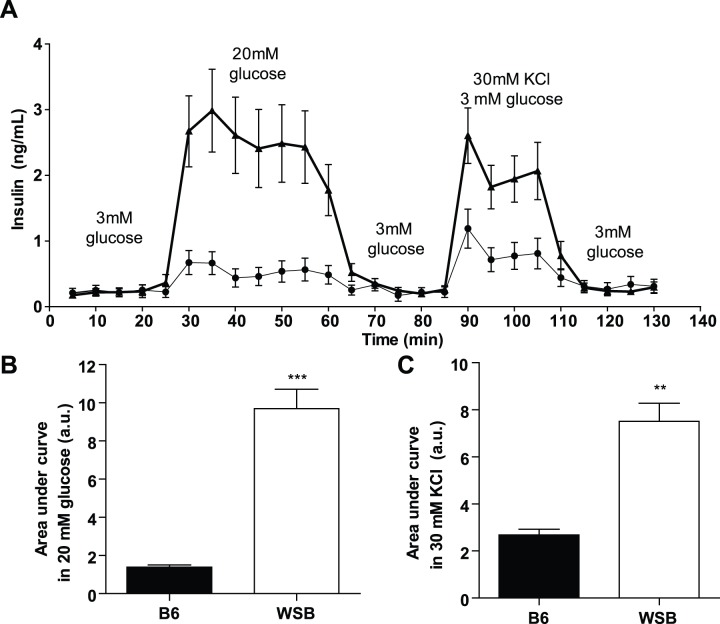
Insulin secretion in WSB mice.A, Insulin secretion response of size-matched B6 and WSB islets in 3 mM basal glucose, 20 mM glucose, and 30 mM KCl for the times indicated. Thin line represents B6 islets, Thick line represents WSB islets. B, Area between insulin secretion curve and average basal glucose insulin response when incubated with 20 mM glucose. C, Area between insulin secretion curve and average basal glucose insulin response when incubated with 30 mM potassium chloride in basal glucose. Perifusions were performed in ∼6 week old mice (n = 10 per strain). **p<0.01, ***p<0.001 vs. B6.